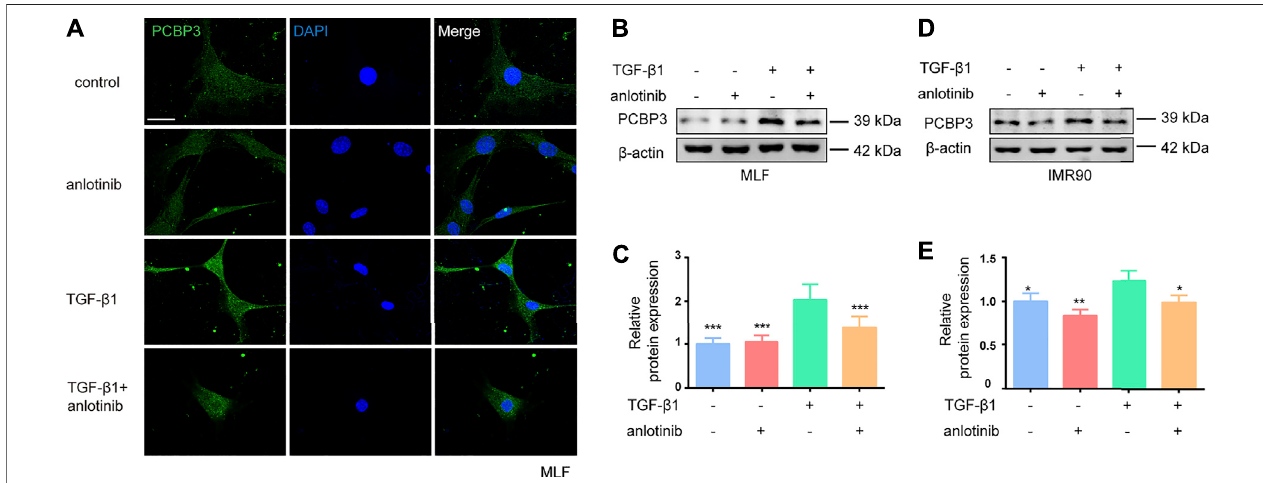
FIGURE 4 | Anlotinib represses PCBP3 expression levels during myo fi broblast activation. (A) Immuno fl uorescence for PCBP3 (green) in mouse lung fi broblasts treatedwithanlotinibfor3 h,followedbyTGF- β 1foranadditional24 h.DAPI-stained nuclei(blue).Scalebar,25 µm. (B) WesternblotsanalysisofPCBP3and β -actinin primary mouse lung fi broblasts. (C) Quanti fi cation for the indicated proteins (mean ± SD, n (cid:1) 3). (D) The Western blots analysis of PCBP3 and β -actin in IMR90 cells treatedwithanlotinibfor3 h,followedbyTGF- β 1foranadditional24 h. (E) Quanti fi cation fortheindicatedproteins(mean ± SD,n (cid:1) 3).* p < 0.05,** p < 0.01,*** p < 0.001 VS TGF- β 1-treated group by